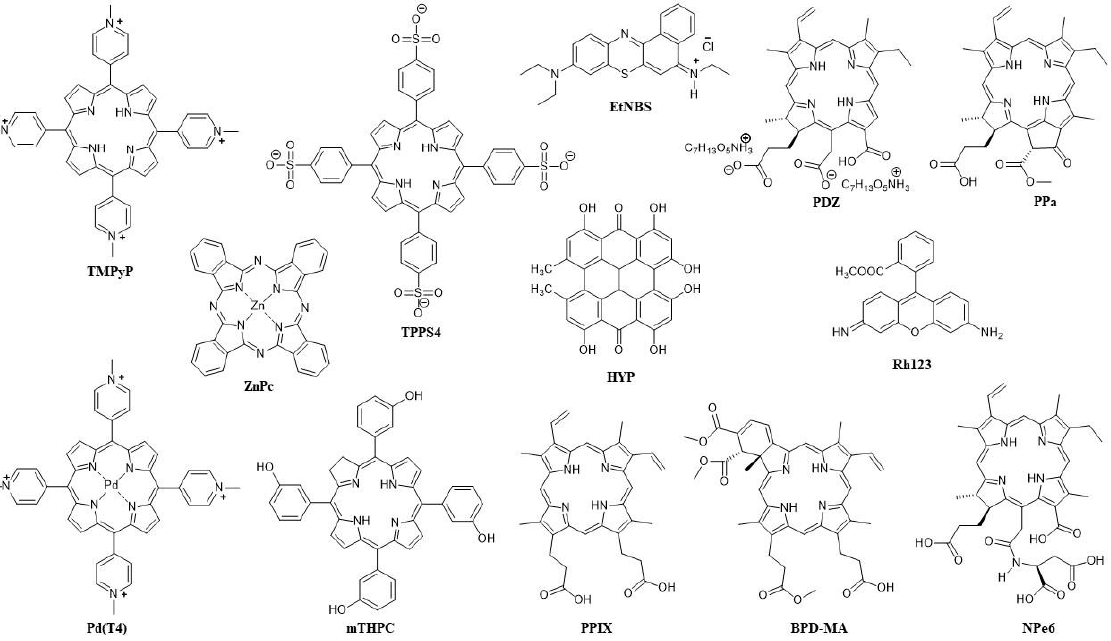
Figure 2. Structures of the PSs used in combination in anticancer PDT and their abbreviations.